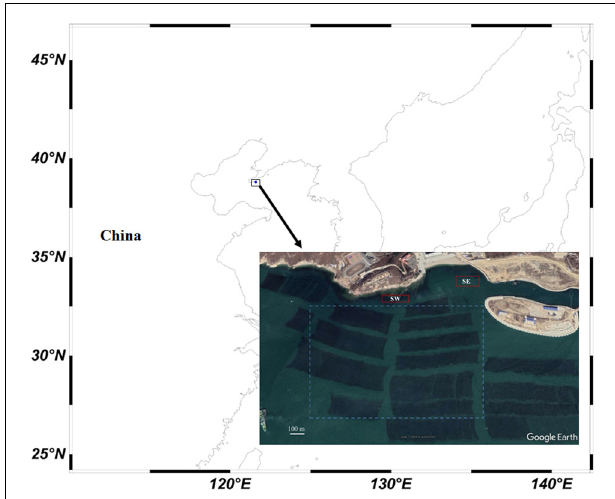
FIGURE 2 | Sampling site of the farmed populations and the adjacent spontaneous populations of Saccharina japonica. Red rectangles indicate the sampling range of the subtidal spontaneous populations SW and SE. Blue dashed rectangle indicates the sampling range of farmed populations and the spontaneous population on the cultivation structural rafts. The dark rectangular areas in the sea are the cultivation infrastructure.